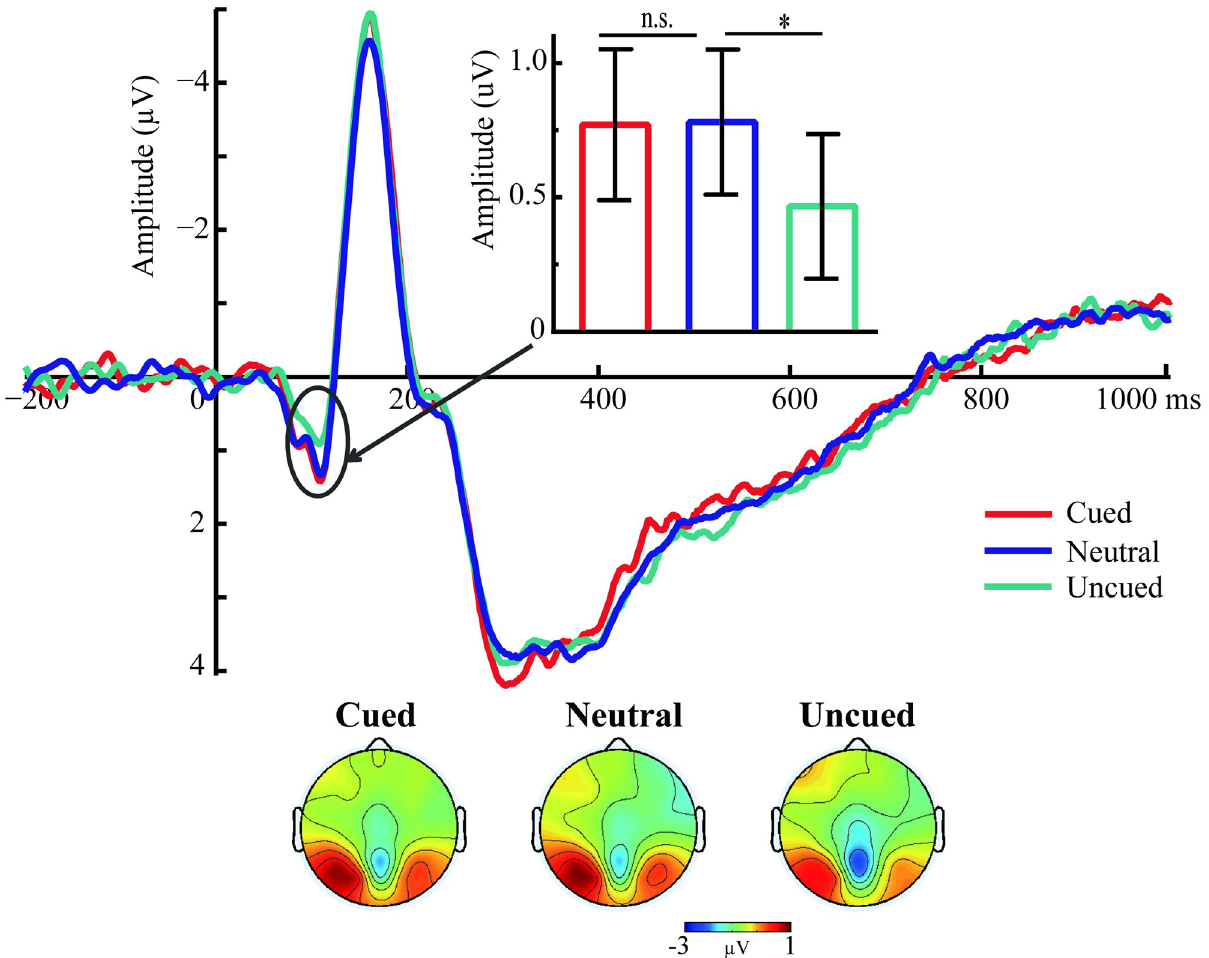
Fig 3. The P1 amplitudes for the search variable at the posterior electrode sites (averaged across electrodes PO7 and PO8) are presented. Topography represents the P1 component measured as the mean amplitude between 60 and 120 ms. The left and right sides of the outline head represent left and right hemisphere locations, respectively. n.s. = non-significant, � p <